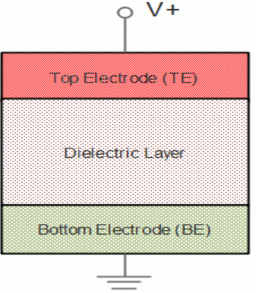
Figure 1. The capacitor-like structure of an RRAM